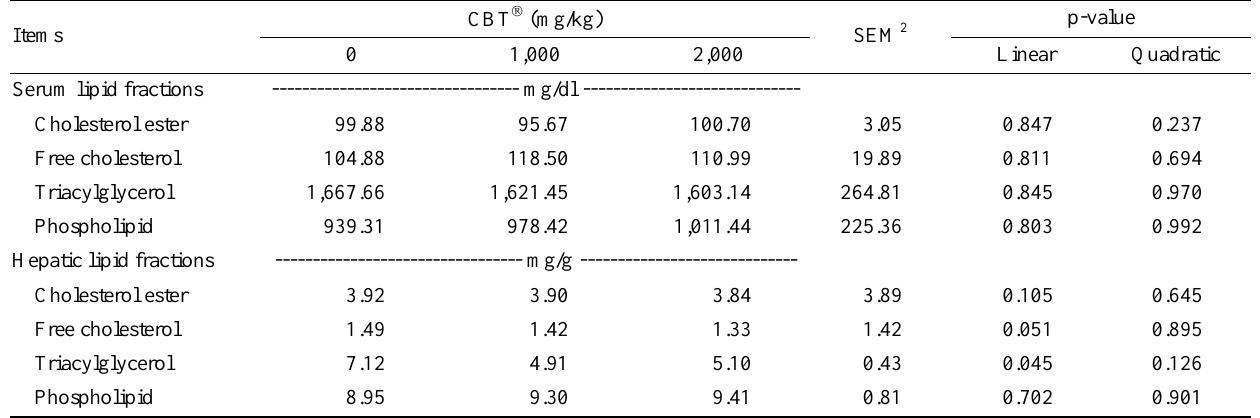
Table 5. Effects of dietary CBT  supplementation on lipid fractions of serum and liver in laying hens 1